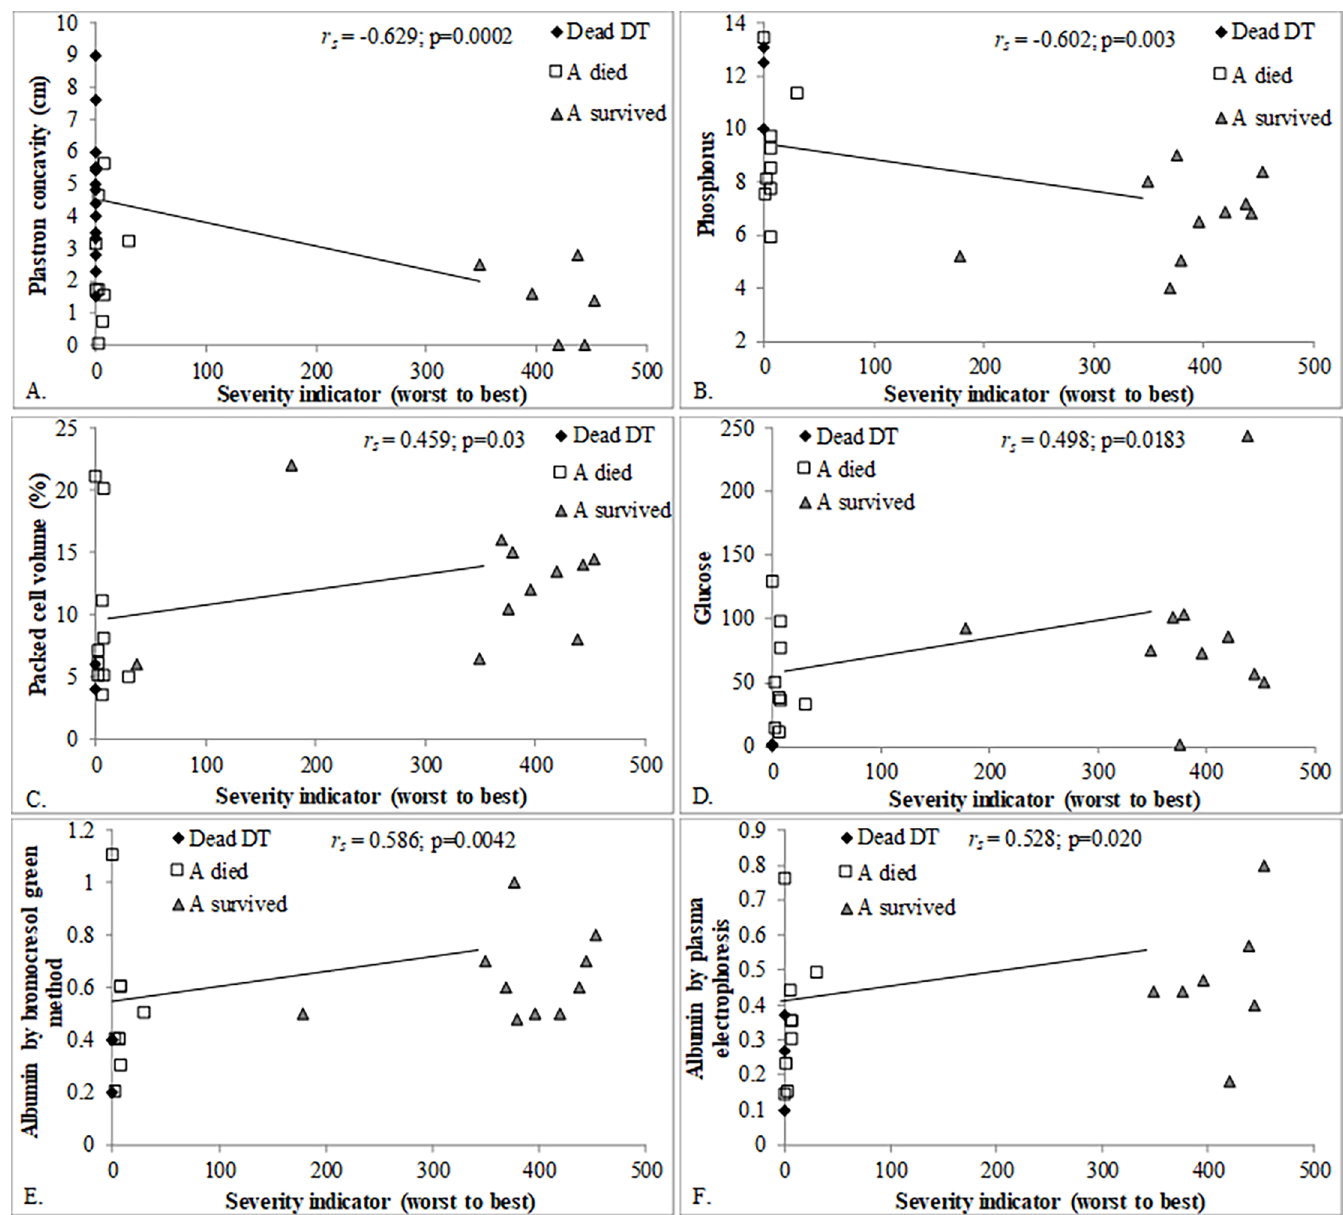
Fig 6. Health variables that significantly correlated with the severity indicator in debilitated loggerhead sea turtles (DTs). Spearman rank correlation coefficients and p-values are shown. (A) plastron concavity; (B) packed cell volume (PCV); (C) glucose; (D) phosphorus; (E) albumin by bromocresol green method; (F) albumin by plasma electrophoresis; (G) B-lymphocyte